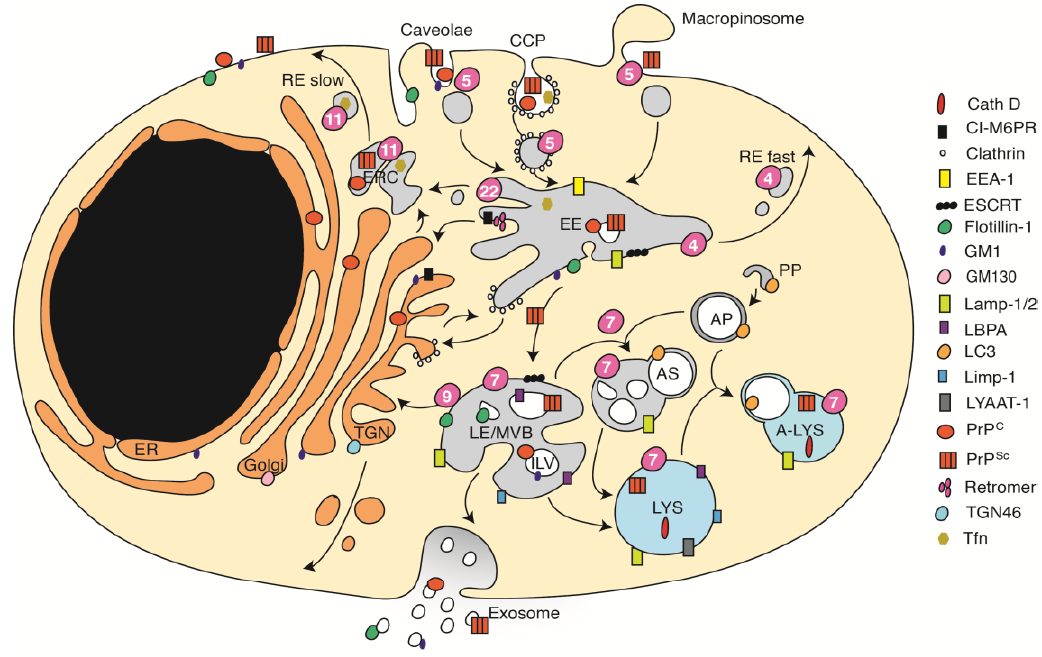
Figure 1. Endocytic vesicle trafficking pathways. Cargo is internalized through clathrin-coated pits (CCP), or clathrin-independent uptake routes via caveolae, rafts, flotillin-1/2 assisted pathways, or bulk uptake via macropinocytosis. Cargo is first sorted to early endosomes (EE), where it is disseminated to specific tubular subcompartments for fast recycling to the cell surface (RE fast), or slow recycling through recycling endosomes (RE slow) and the endocytic recycling compartment (ERC). Alternatively, cargo can be subject to retrograde transport to the trans-Golgi network (TGN). Cargo destined for degradation is trafficked to late endosomes/multivesicular bodies (LE/MVBs). LE/MVBs containing intraluminal vesicles (ILVs) can fuse with the plasma membrane to secrete cargo-loaded ILVs as exosomes. For cargo clearance, LE/MVBs fuse with lysosomes (LYS) or autophagosomes (AP) to form amphisomes (AS) that subsequently fuse with lysosomes. Autophagosomes can also directly fuse with lysosomes to form autolysosomes (A-LYS). Also, anterograde crosstalk between the TGN and endocytic pathway exists (not shown). Cellular locations of PrP C , PrP Sc , and marker proteins/lipids are indicated. RabGTPases, key regulators of intracellular vesicle trafficking, are numbered and symbolized by purple circles. Rab7a, Rab11a, and Rab22a regulate the dynamics of RE that emerge from EEs [86]. Cath D: Cathepsin D; LC3: lipidated form LC3-II; Tfn: Transferin. Note that the cellular distribution of marker proteins/lipids varies slightly for different cell types and in differentiated versus undifferentiated cells.